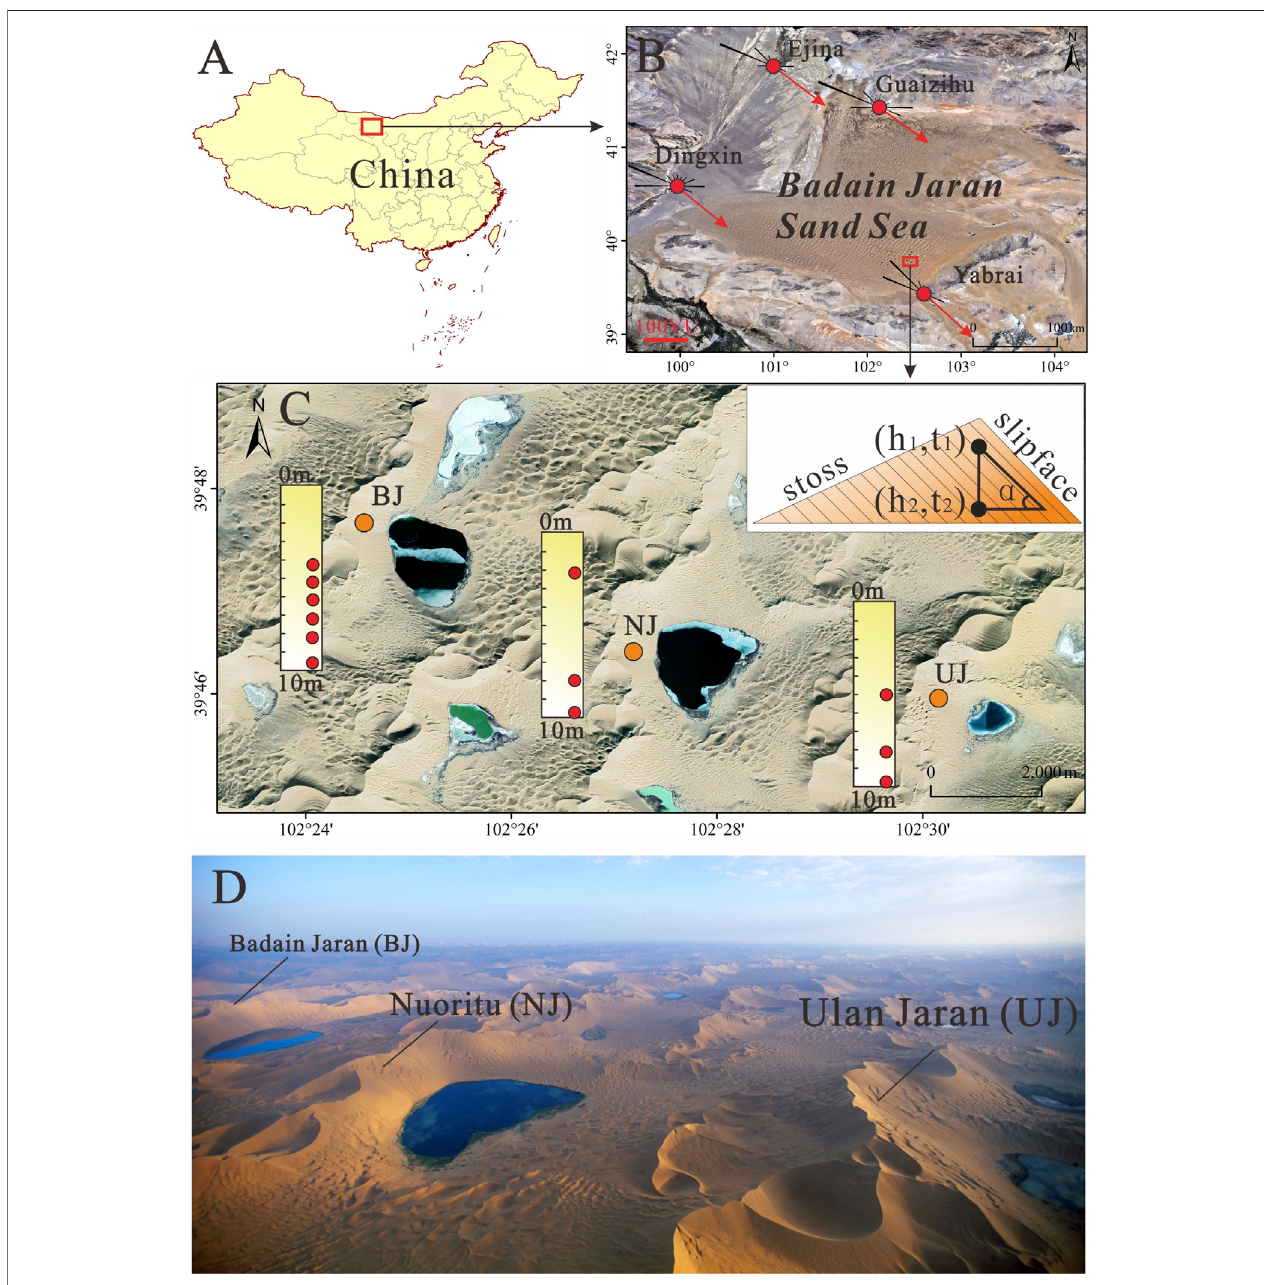
FIGURE1|(A,B) LocationoftheBadainJaranSandSeaandwindregime;thesanddriftpotentialiscalculatedbasedontheERA5ReanalysisData(www.ecmwf. int). (C) Three megadune drill cores (orangedots) in the Badain Jaran Sand Sea and OSL sampling sites (red dots). The inset graphical representation of the parameters used to estimate the rate of advancement. (D) Aerial image of the three megadunes (Source: Dong et al., 2013).